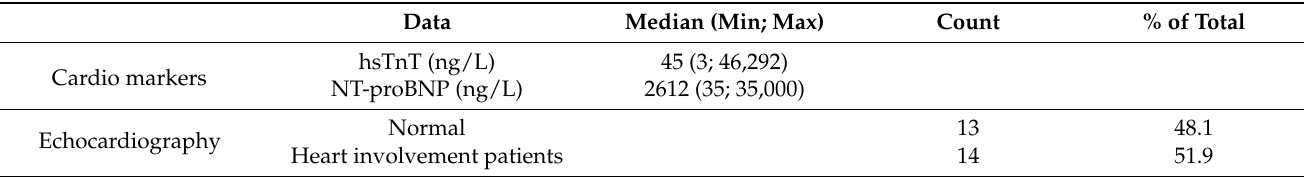
Table 4. MIS-C: initial cardiac parameters.